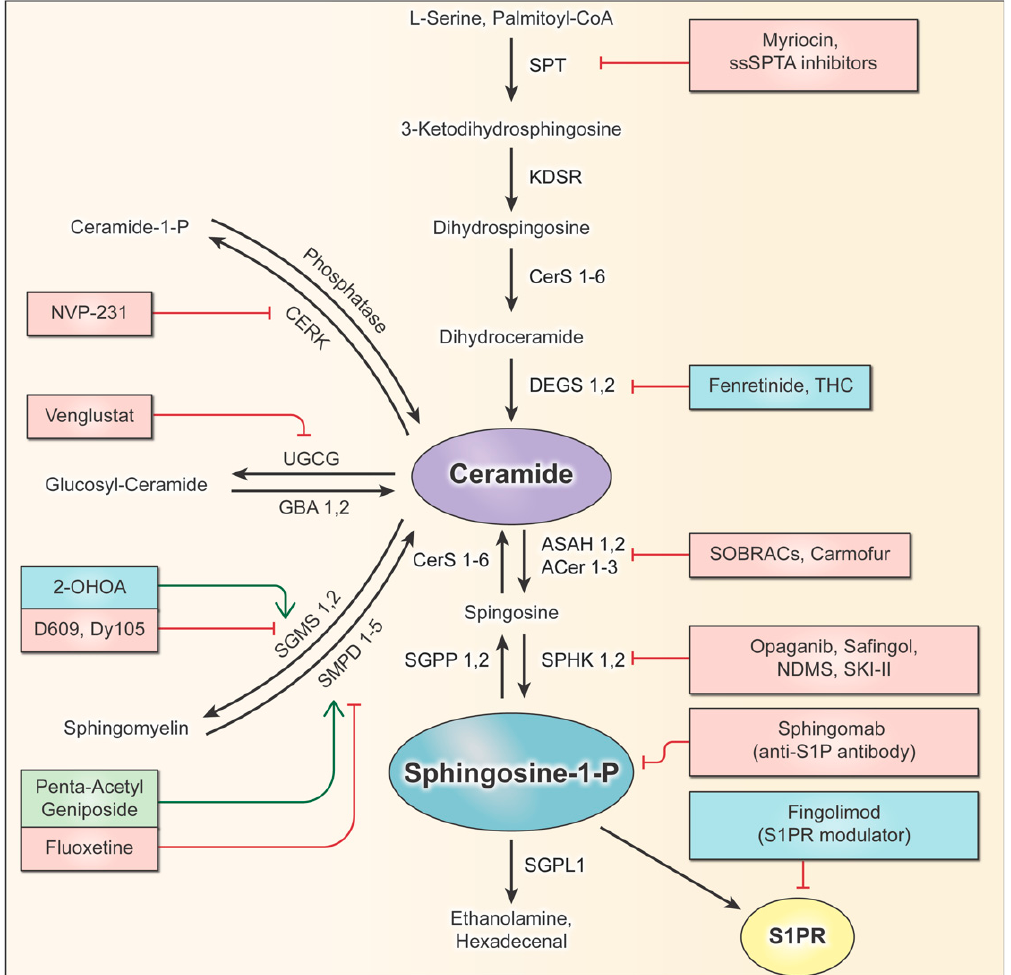
Figure 3. Sphingolipid pathway and the fates of ceramide. Drugs that have been involved in clinical trials on glioma patients (listed in Table 1) are in blue boxes. Pre-clinical drugs are listed in red or green boxes, depending on their status as inhibitors or activators. Additional research translating preclinical drugs may result in novel clinical trials on glioma patients and other cancer types. SPT, serine palmitoyl-CoA transferase; KDSR, keto-dihydrosphingosine reductase; CerS, ceramide synthase; DEGS, dihydroceramide desaturase; SGMS, sphingomyelin synthase; SMPD, sphingomyelinase; CERK, ceramide kinase; C1PP, ceramide 1-phosphate phosphatase; UGCG, UDP-glucose ceramide glucosyltransferase; GBA, glucocerebrosidase; ASAH/ACER, ceramidase; SPHK, sphingosine kinase; SGPP, sphingosine phosphate phosphatase; SGPL, sphingosine phosphate Table 1. Clinical trials on sphingolipid modulators in brain tumor